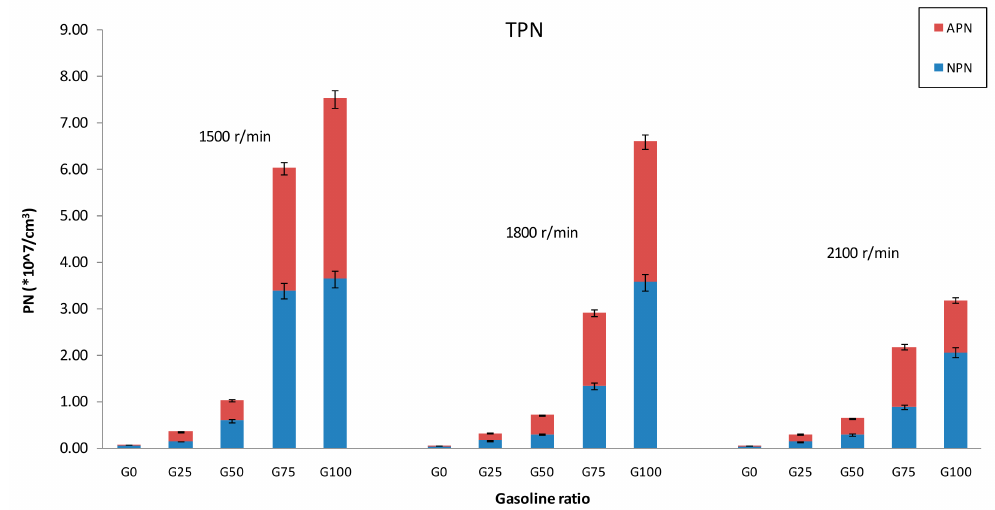
Figure 11. Particle number with R e for di ff erent speed (The direct injection timing is 180 ◦ CA BTDC. The ignition timing is MBT. The intake manifold absolute pressure is 56